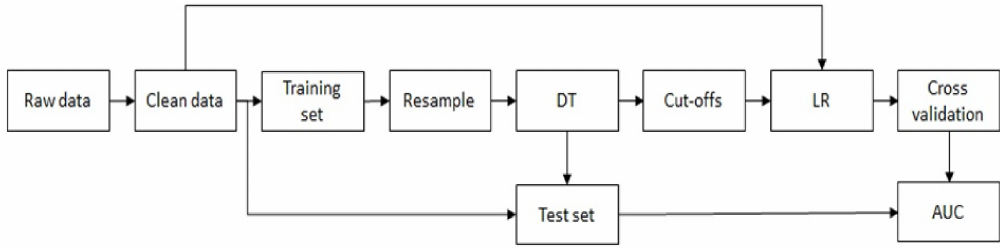
Figure 1. Data mining process. DT: decision tree; LR: logistic regression; AUC: area under